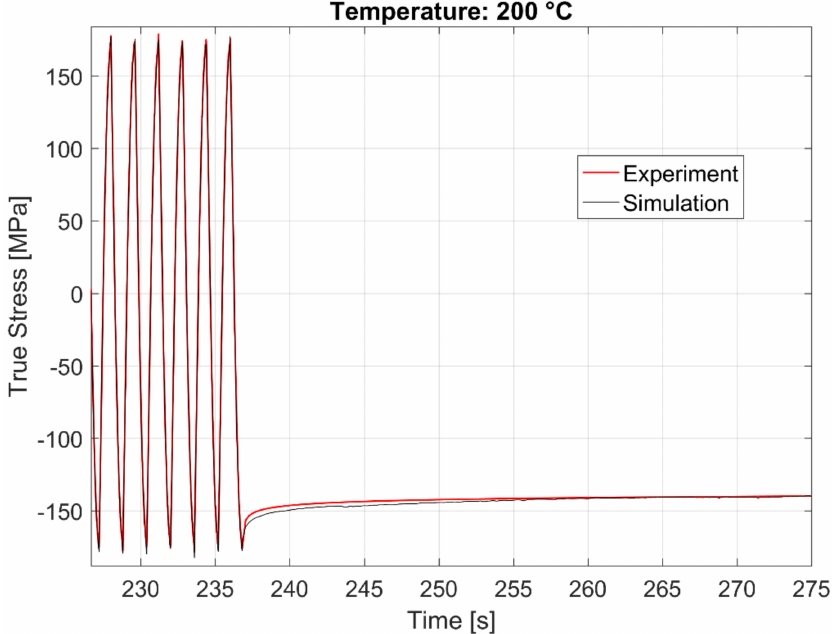
Figure 25. Time history of the experimental vs. visco-plastic model prediction at 200 ◦